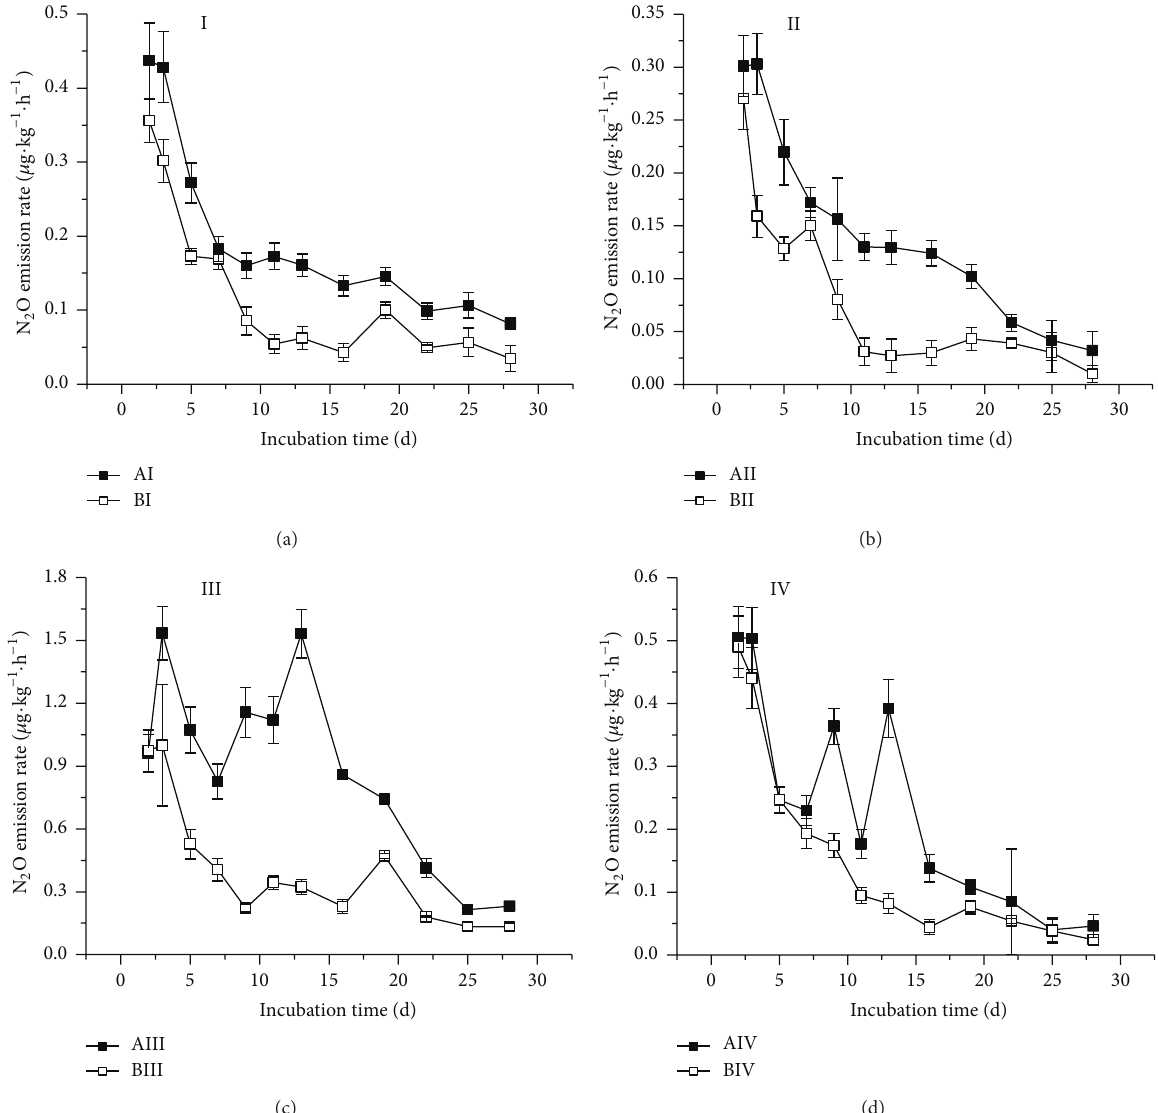
Figure 1: N 2 O emission rate of the treatments studied. (Treatments notations are as follows: A: incubation at 35 ∘ C; B: incubation at 20 ∘ C; I: peat soil; II: peat soil under flooding; III: peat soil plus raw organic matter; IV: peat soil under flooding plus organic